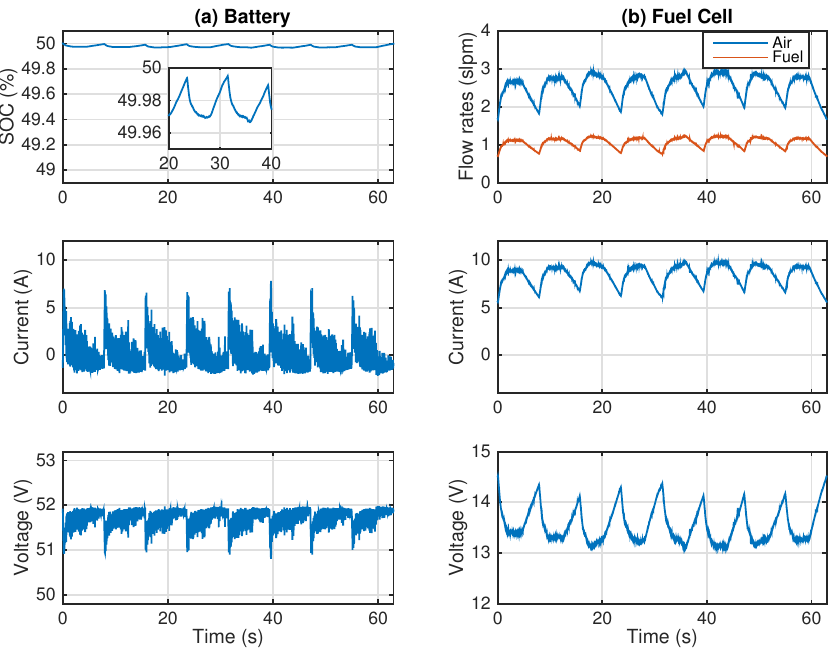
Figure 21. Medium-SOC semi-active hybrid simulation. ( a ) Battery response and ( b ) FC response. The simulation results for low-SOC can be seen in Figure 22. It shows how the FC is able to cover the load needs and charge the battery with extra power when providing a constant 10 A of current. As in this period the FC has been able to charge the batteries, it means that the battery will not be depleted while there is hydrogen available.